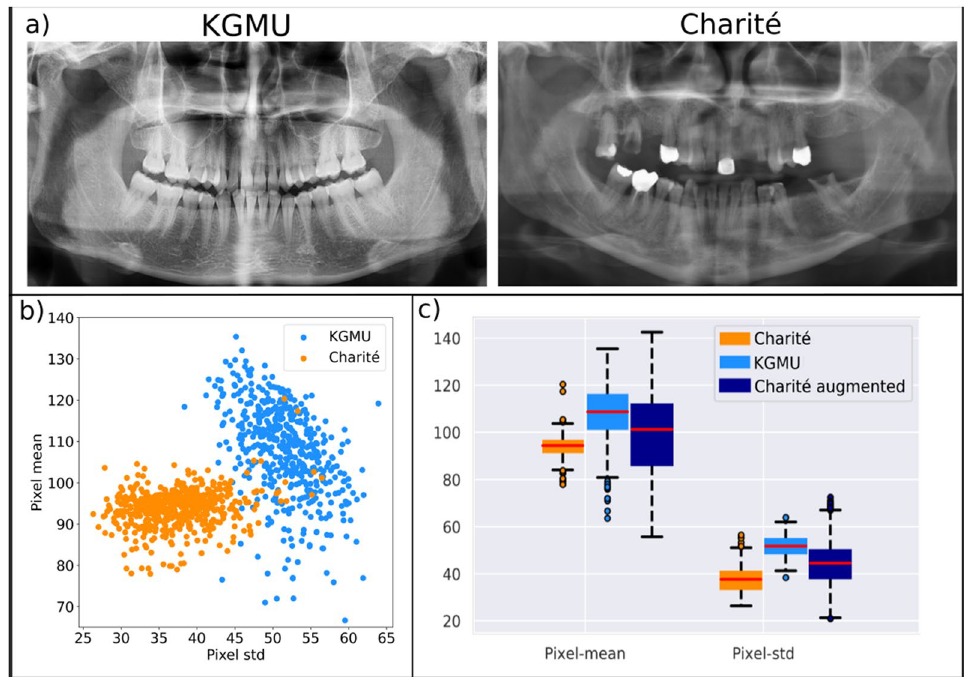
Figure 2. Differences between the Charité and KGMU sets. ( a ) Representative images of the KGMU and Charité datasets, showing the typical observed differences in population characteristics (number of teeth, presence of dental restorations) and image conditions (brightness and contrast). ( b ) The plot of the pixel means (proxy for brightness) and standard deviations (proxy for contrast) of images included in the training sets. ( c ) Boxplots of the pixel means and standard deviations of the Charité and KGMU images in the training sets as well as of the same Charité images after application of the pixel-wise transformations by data augmentation. Box and line: 25/75th percentiles and median. Whiskers: Minimum/maximum or 1.5 inter quartile rage if outliers are present; Dots: